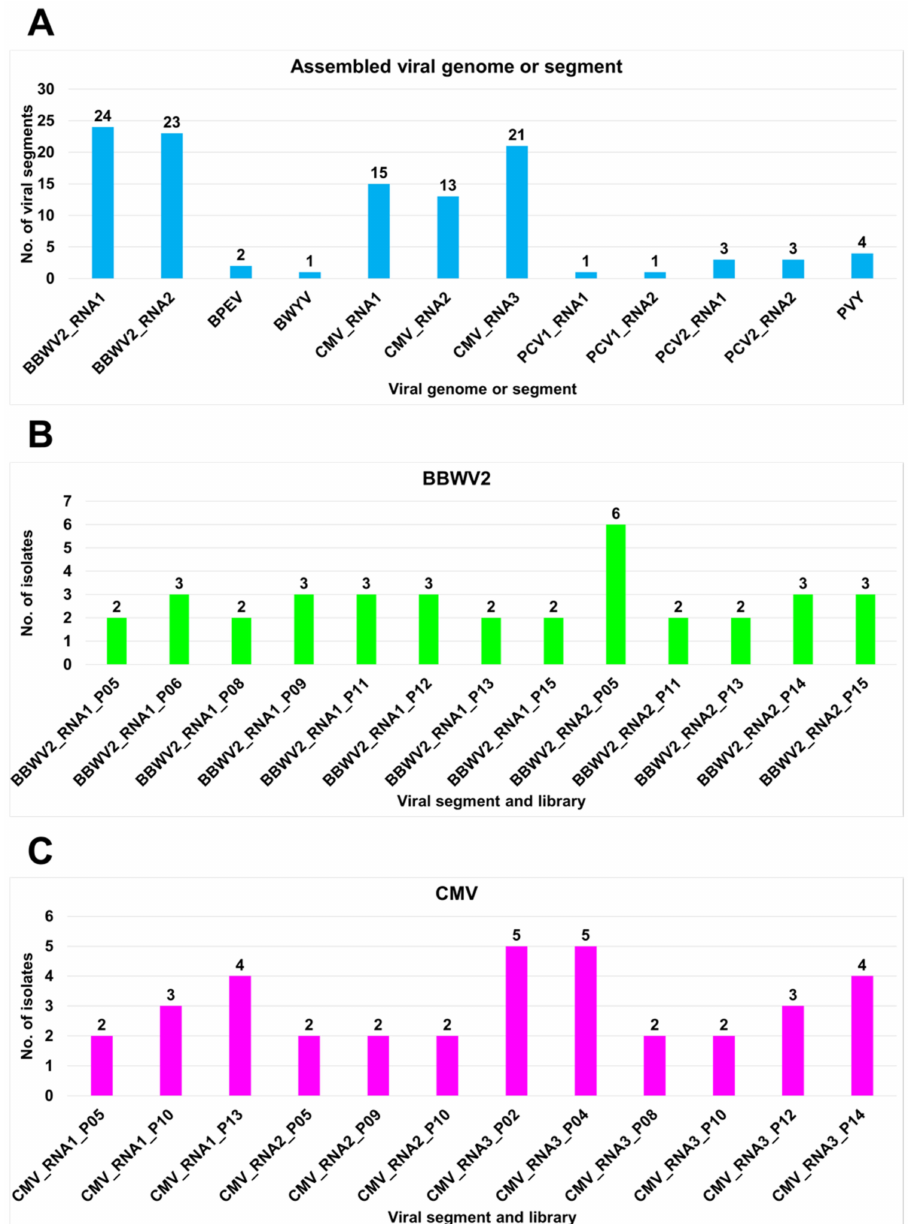
Figure 5. Number of assembled viral genomes: ( A ) total number of viral genomes or viral segments de novo assembled from RNA sequencing; ( B ) number of assembled viral variants for BBWV2 in each library; ( C ) number of assembled viral variants for CMV in each library. For viruses with multiple RNA segments, the number of assembled viral genomes is indicated by each viral segment. Although we identified two alphaendornaviruses, HPEV and BPEV, only two complete genomes of the BPEV variants, P14 and P15, were obtained. The phylogenetic tree using 24 BPEV isolates demonstrated that P14 and P15 belonged to group A containing 18 BPEV isolates (Figure 6B). Most of the BPEV isolates in group A were closely related. In contrast, the six BPEV isolates in group B were distantly